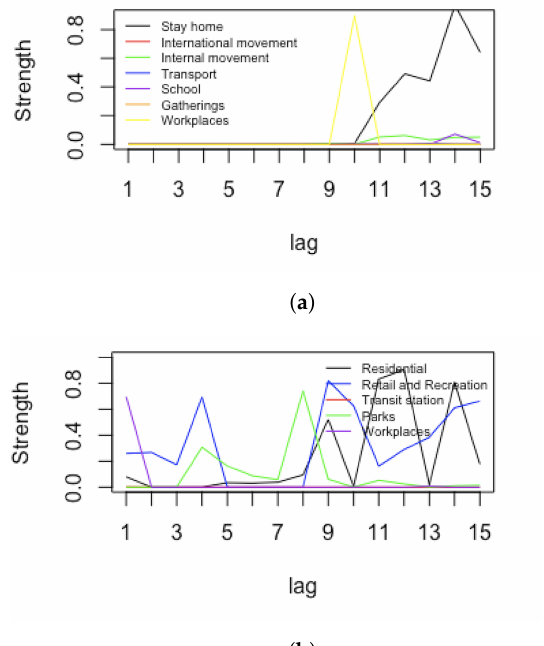
Figure 13. Strength analysis for Israel. Arc strengths according to different lags. Restriction nodes vs. hospitalisations node ( a ) and mobility nodes vs. hospitalizations node ( b